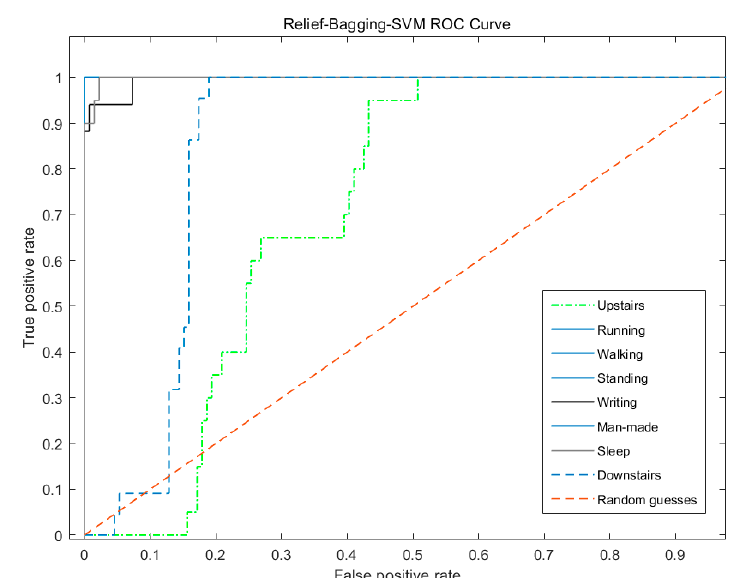
Figure 11. Relief ‐ bagging ‐ SVM ROC curve. Figure 11. Relief-bagging-SVM ROC curve.